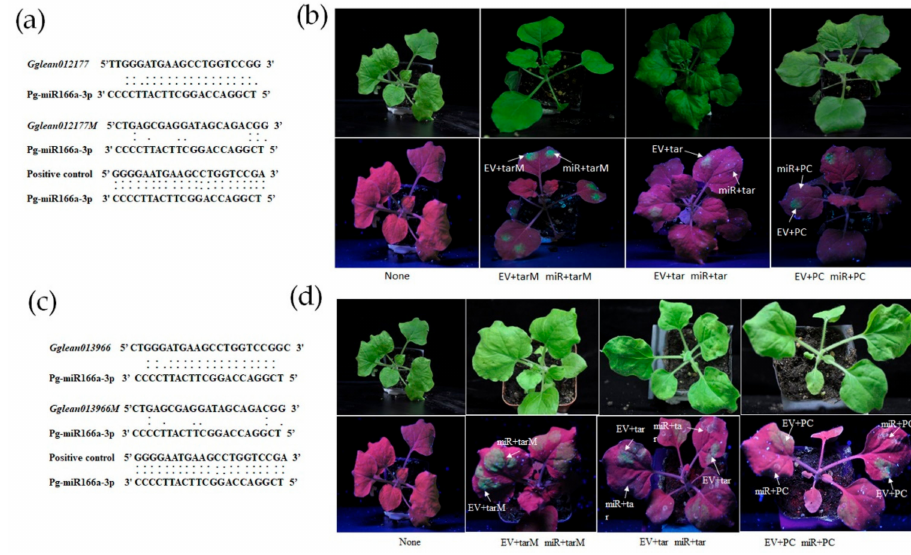
Figure 5. Pg-miR166a-3p targeted Gglean012177.1 and Gglean013966.1 was verified in vivo: ( a ) The alignment of the sequence of pg-miR166a-3p with the target site in Gglean012177 , the negative control and the positive control; ( b ) verification of the interaction between pg-miR166a-3p and Gglean012177.1 ; ( c ) the alignment of the sequence of pg-miR166a-3p with the target site in Gglean013966 , the negative control and the positive control; and ( d ) verification of the interaction between pg-miR166a-3p and Gglean013966.1 . ”:” in the picture represent the complementary site; None, tobacco without anything injection; EV, PBI121 empty vector; tarM, the negative control ( Gglean012177M / Gglean013966M ); tar, the target site of pg-miR166a-3p in Gglean012177.1 and Gglean013966.1; miR, pre-pg-miR166a-3p-PBI121; and PC, the positive